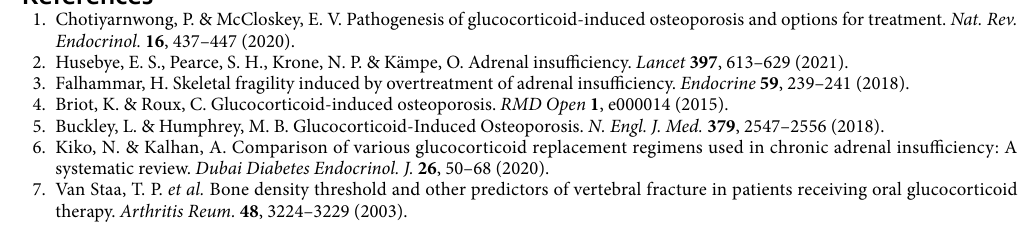
Table 4. Variables independently associated with the fracture rate after 5 years of conventional steroid replacement therapy (group A) at multivariate analysis.